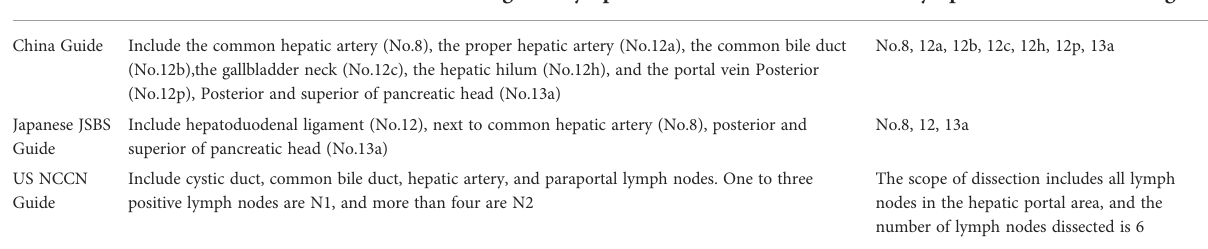
TABLE 3 Statements in different guidelines on the extent of lymph node dissection in gallbladder